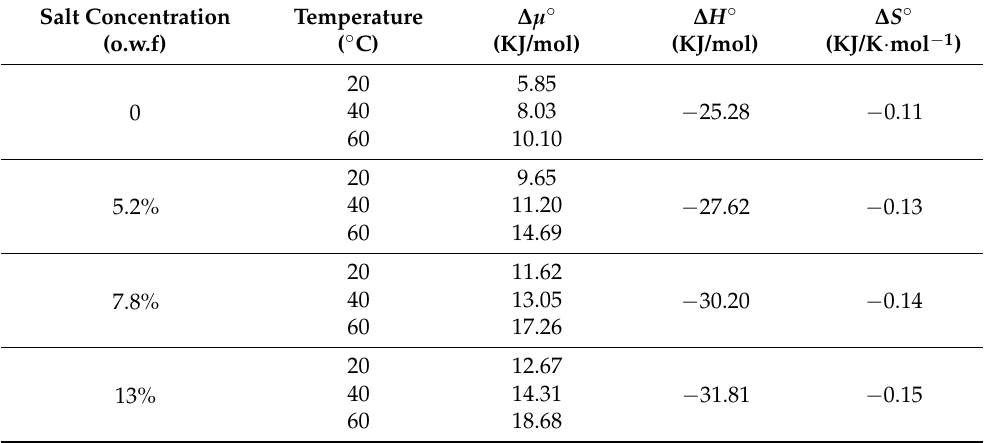
Table 4. Thermodynamic parameters of dye diffusion under different salts concentration. Salt Concentration